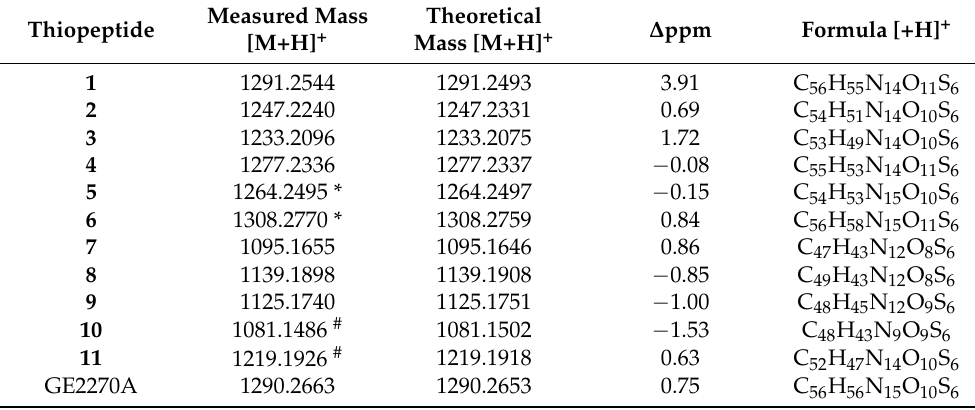
Table 2. Summary of thiopeptides identified using molecular networking and manual observations of the data. Measured Mass Thiopeptide [M+H]